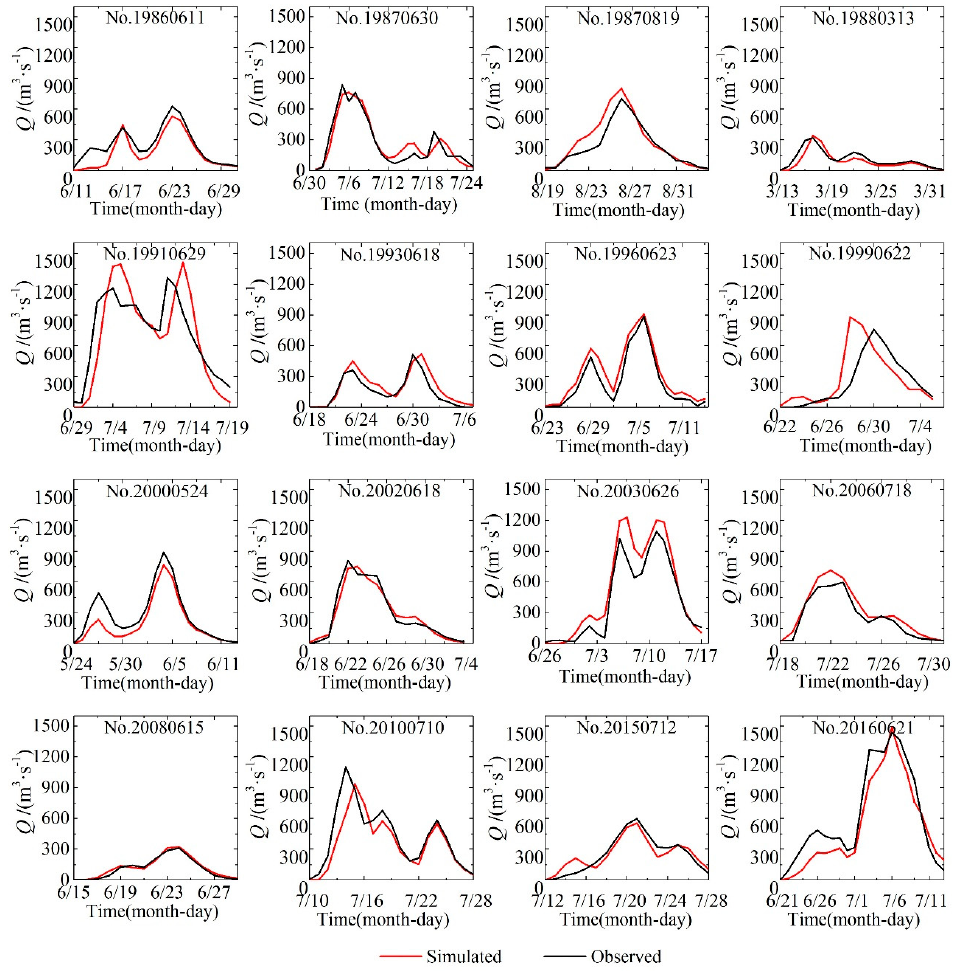
Figure 5. The comparison of simulated and observed hydrographs. Water 2019, 11, 1418